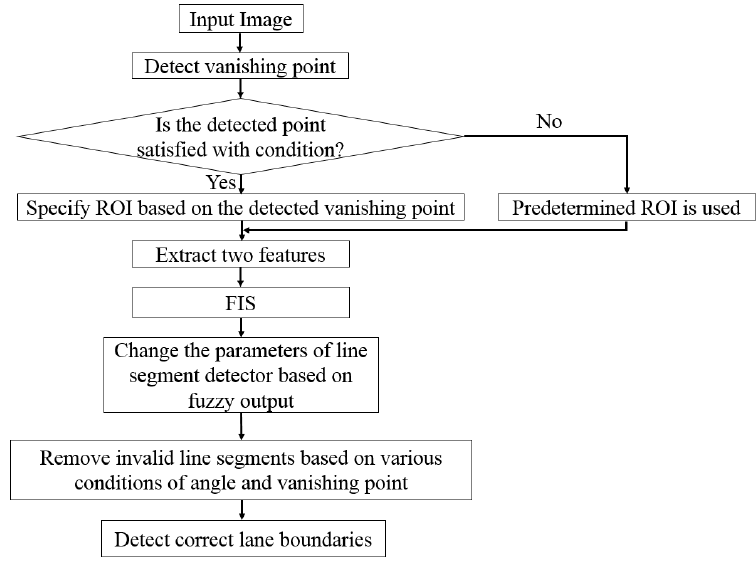
Figure 1. Overall procedure for the proposed method.